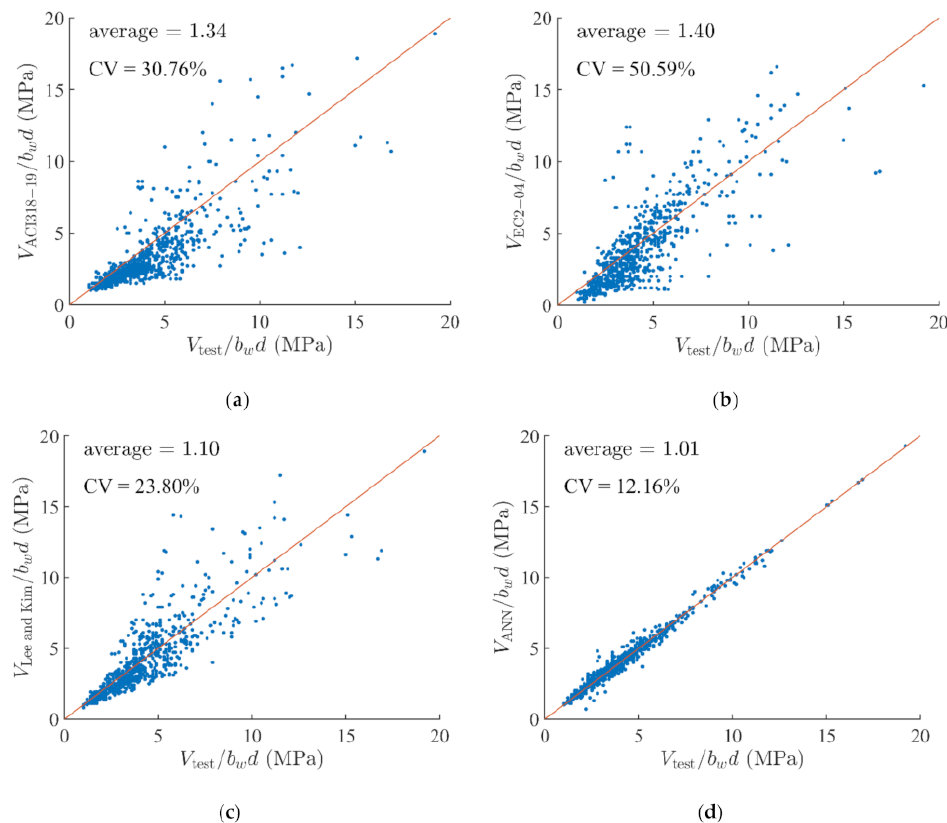
Figure 3. Comparisons between prediction and actual measurements. x -axis represents the prediction and y -axis presents the measurement. Average is the average of V test / V code whereas CV (coefficient of variance) is calculated as standard deviation of V test / V code divided by the average of V test / V code . The subscript, code, for each figure is ( a ) ACI 318-19, ( b ) EC2-04, ( c ) Lee and Kim, and ( d ) ANN with